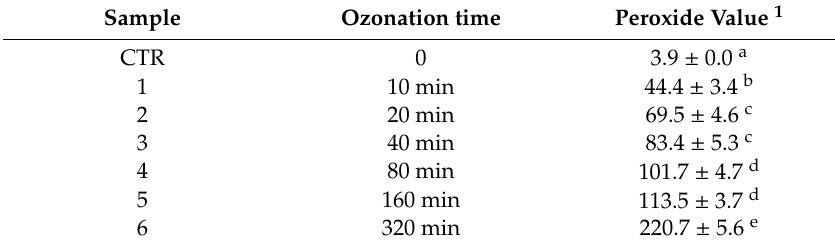
Table 1. E ff ect of ozone treatment on peroxide values. Values are presented as mean ± standard deviation ( n = 2).